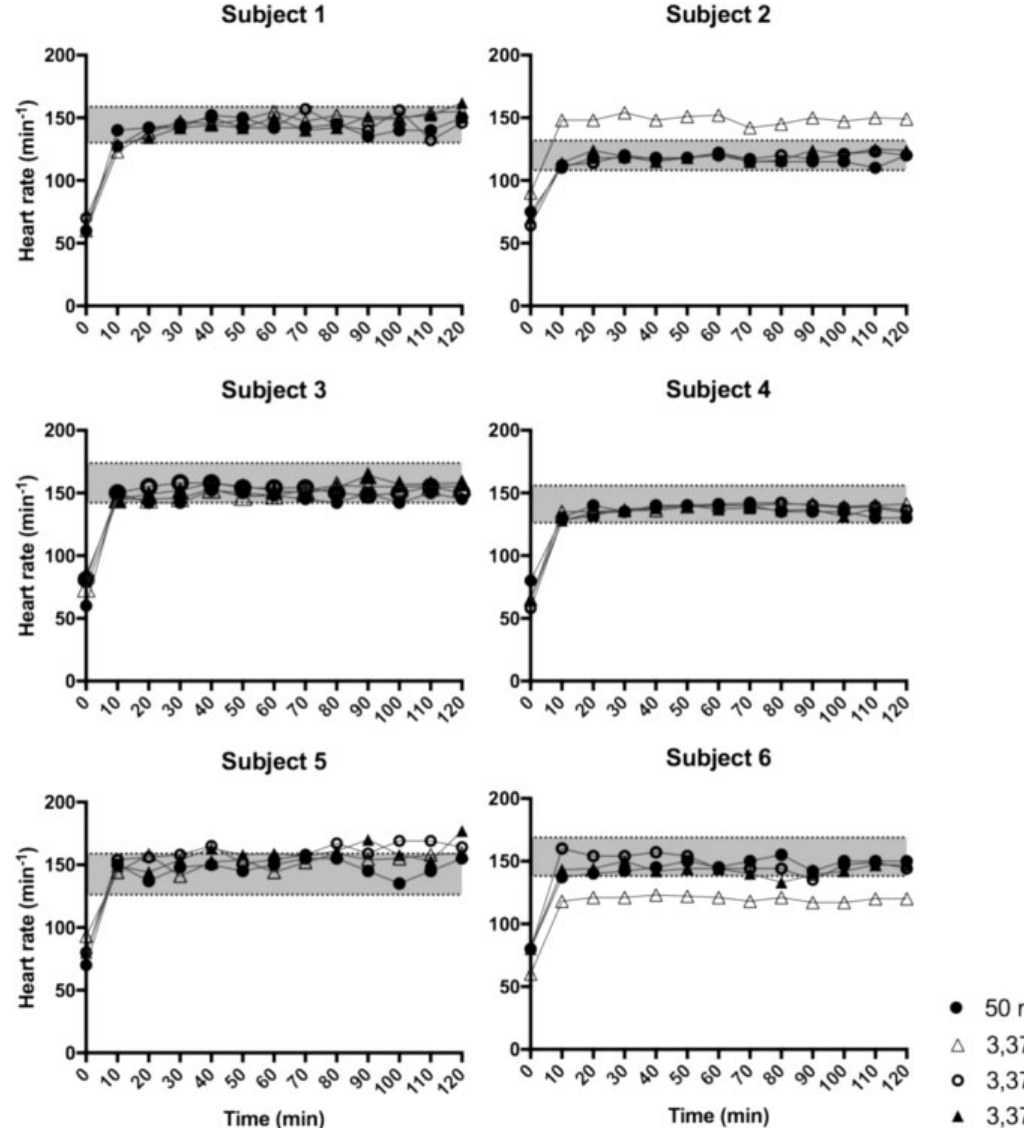
Fig. 6 Individual heart rate traces during the exercise tests. Participants performed monitored exercise for 2 hours on four occasions: 1 time at 50m altitude, and three times at 3,375m altitude. Heart rate (HR, beats per minute) was noted every 10 minutes and participants were encouraged to keep their HR between 60 and 85% of their personal prede fi ned HR reserve (HRR). The gray area on the graphs represents 60 to 85% of